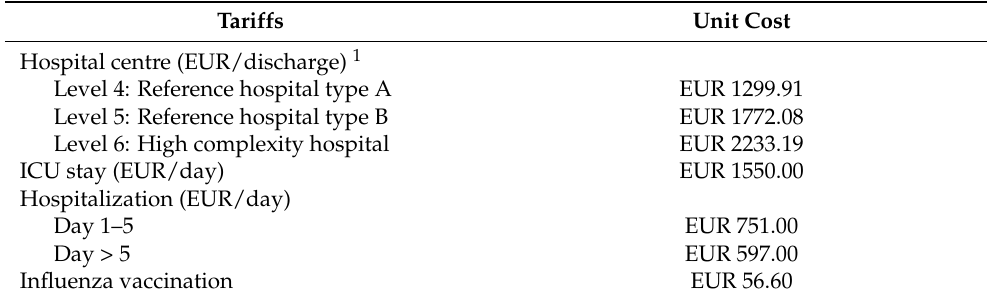
Table 1. Unit costs of hospital discharge, ICU stay, hospitalization and influenza vaccination.